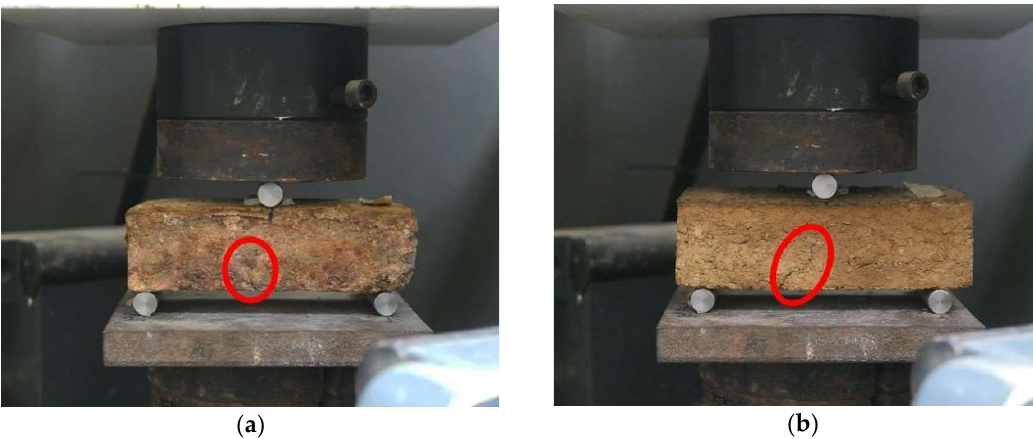
Figure 9. ( a ) Rice Bran with mycelium (RBM) brick specimen tensile failure crack; ( b ) sawdust with Figure 9. (a) Rice Bran with mycelium (RBM) brick specimen tensile failure crack; (b) sawdust with mycelium (SDM) brick specimen tensile failure mycelium (SDM) brick specimen tensile failure crack.